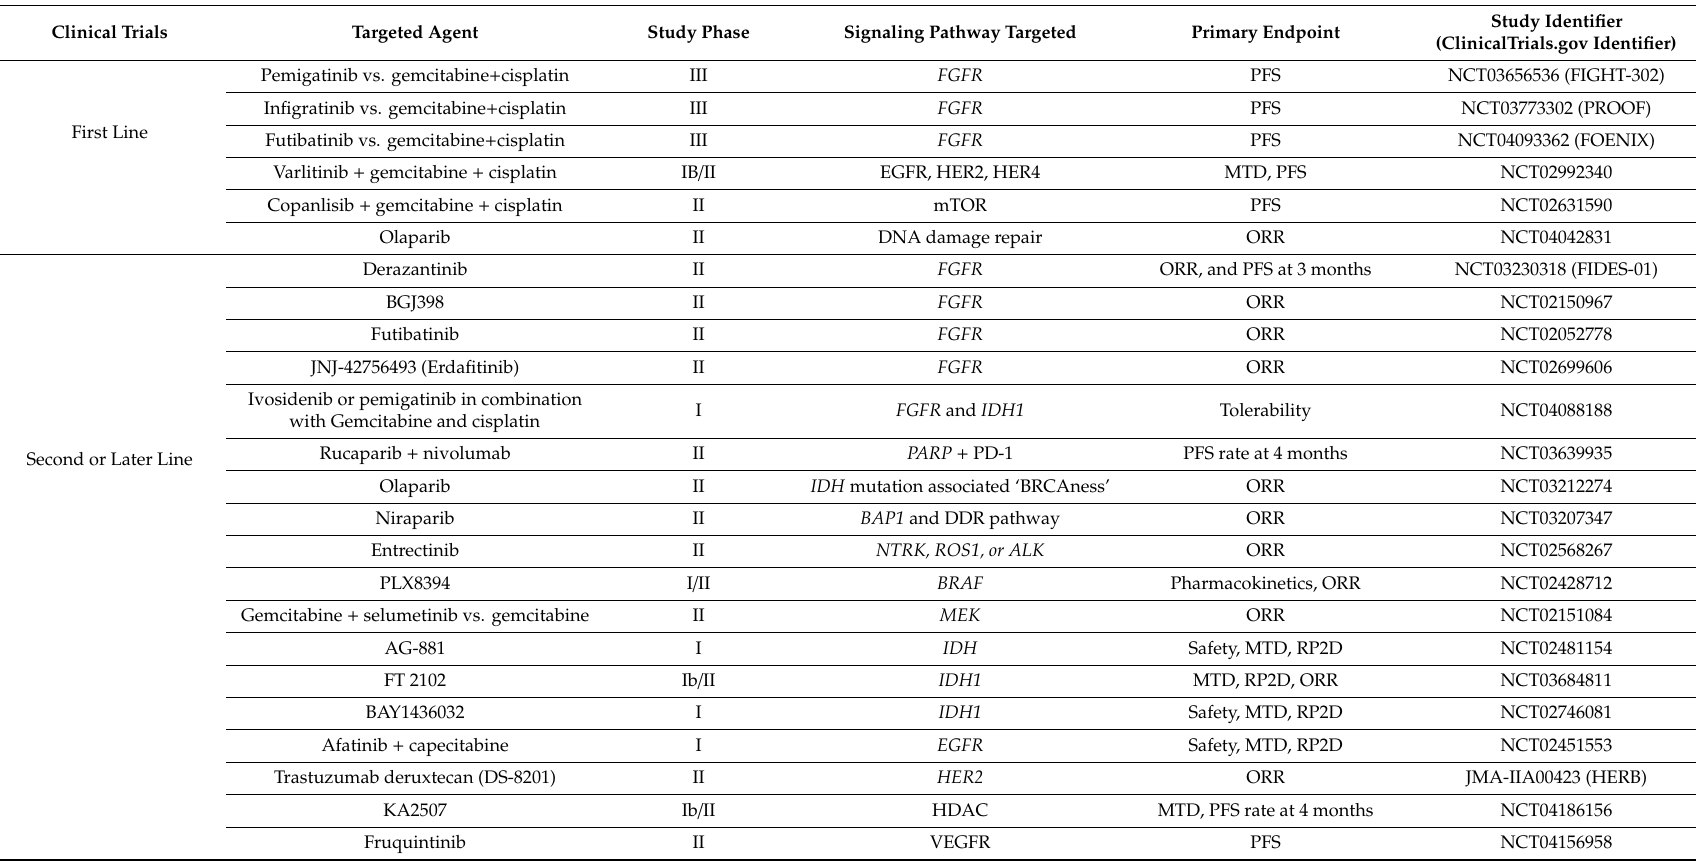
Table 4. Selected ongoing and upcoming clinical trials evaluating targeted therapies in patients with advanced biliary tract cancer